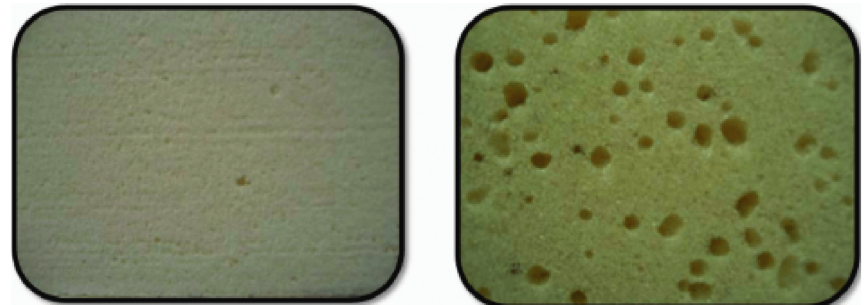
Figure 6: Closed and open polyurethane